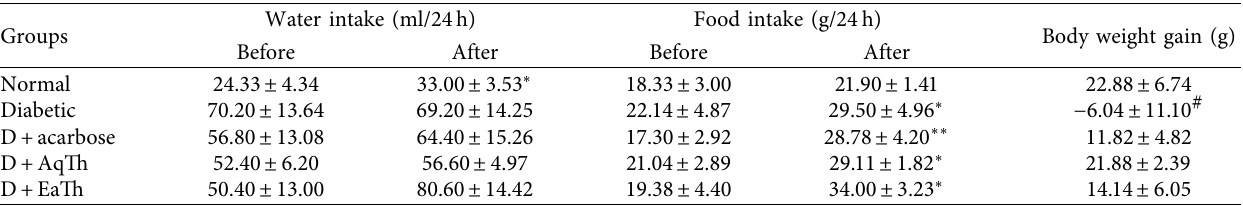
Table 1: Effect of 200mg/kg AqTh, 50mg/kg EaTh, and 10mg/kg acarbose on daily water and food intake and on body weight gain, in STZ- induced diabetic rats after 4-week treatment.